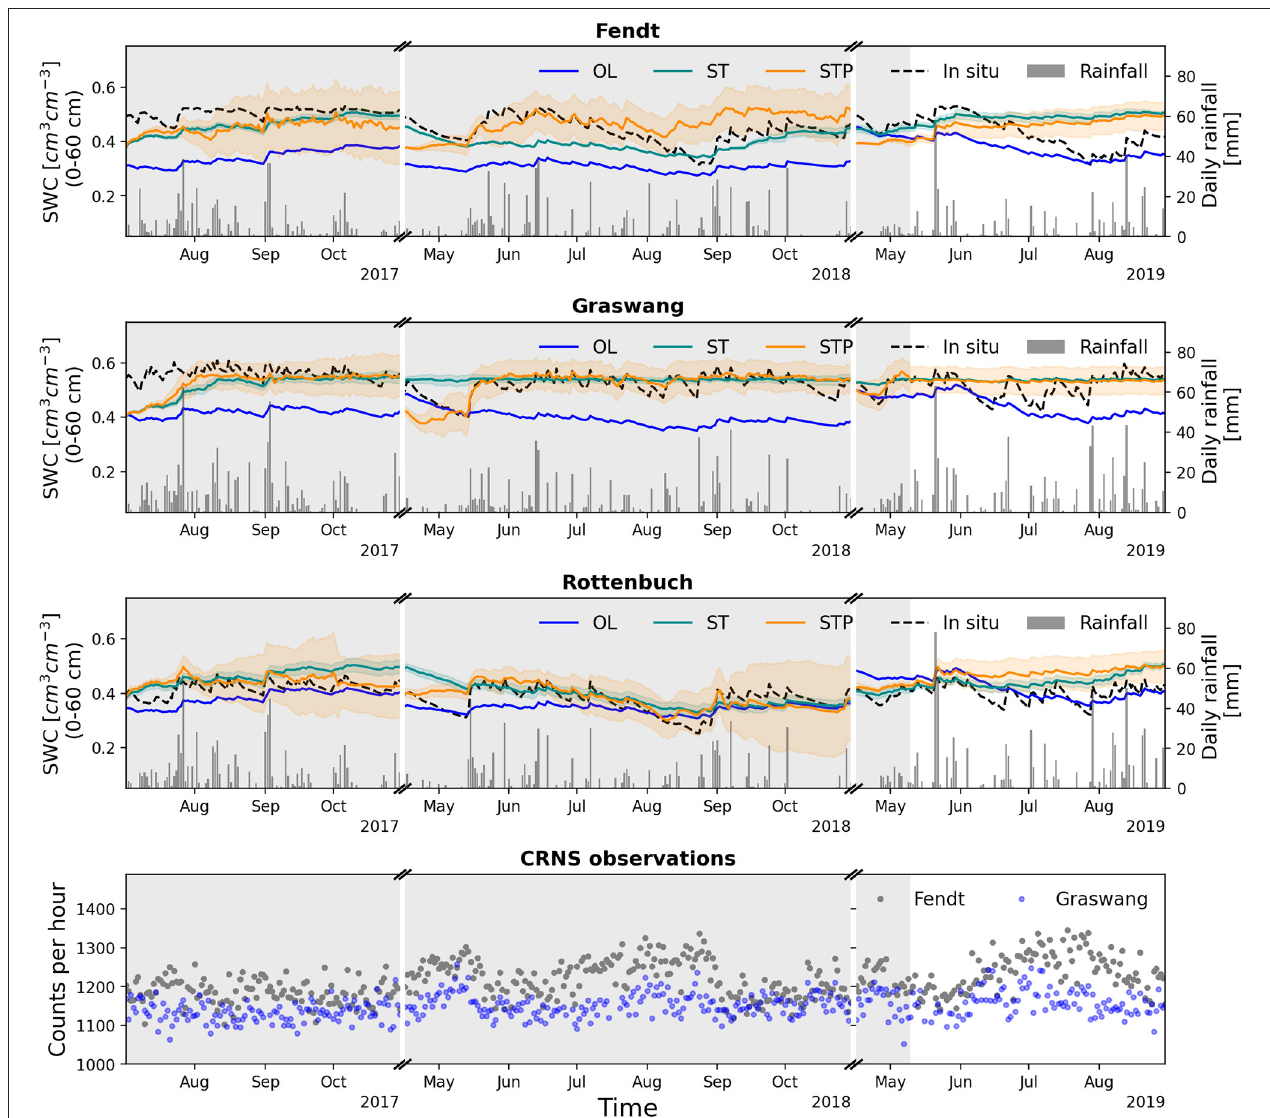
FIGURE 3 | Temporal evolution of simulated soil moisture for the root zone (0–60 cm) from the open loop (OL), state estimation (ST) and state parameter estimation (STP) model runs during the assimilation (1 July 2017–09 May 2019) and evaluation (10 May 2019–30 Aug 2019) period at Fendt, Graswang and Rottenbuch observation sites along with observed ( in-situ ) soil moisture and Rainfall. The temporal evolution of observed CRNS neutron counts at Fendt and Graswang site are also shown as gray and blue dots, respectively. The aggregated SWC estimates were obtained by depth weighted averaging from all soil layers within the root zone